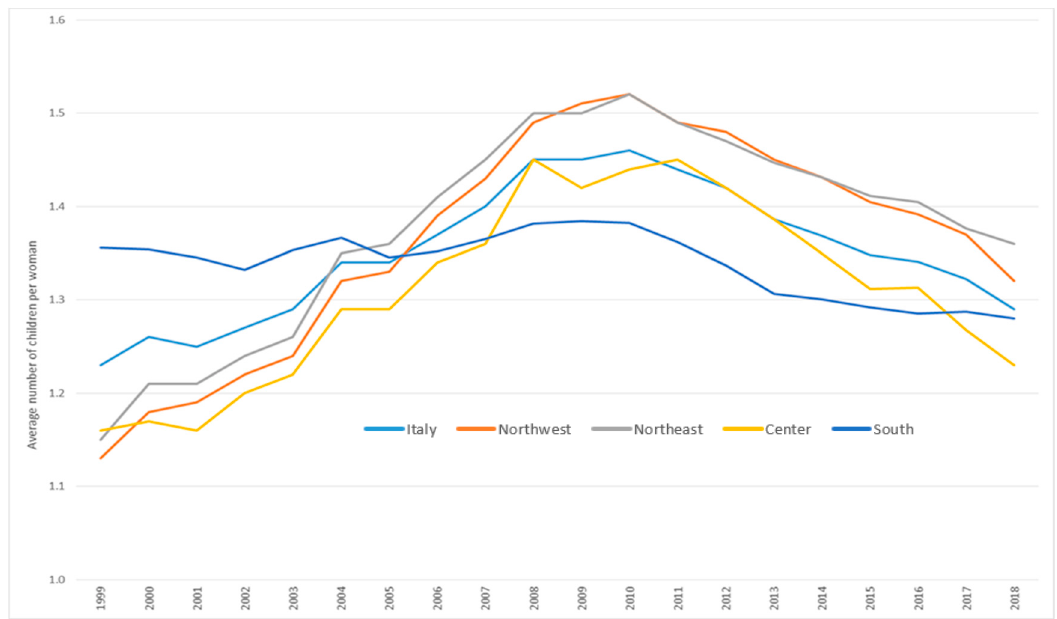
Figure 7. Total fertility rate among women (15–49 years old) in Italy overall and by area of residence. Italy, 1999–2018. Source: Population Register of the Italian National Institute of Statistics (Istat).